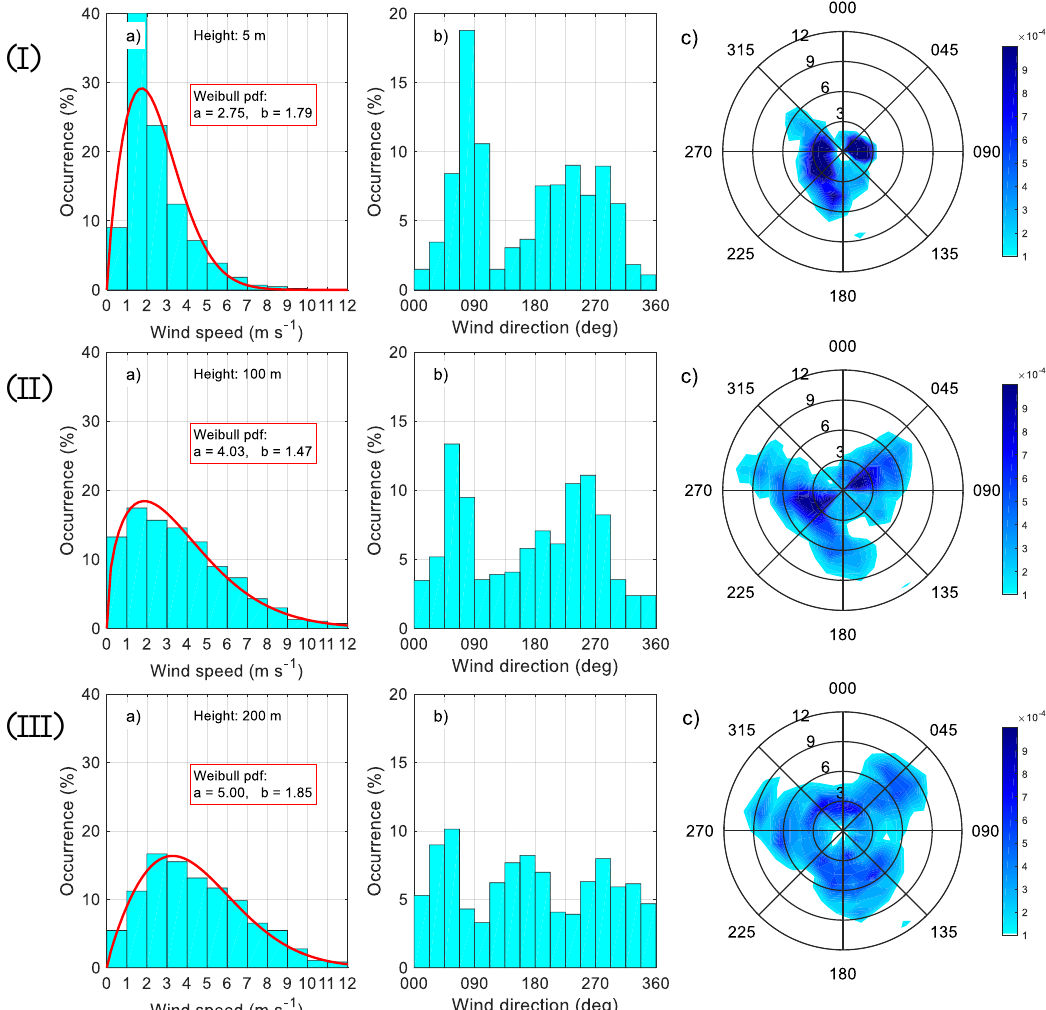
Figure 7. Histograms of ( a ) wind speed and ( b ) wind direction, as well as ( c ) occurrence wind rose diagrams at different heights and different wind speeds values for the summer months June–August in 2015–2016. Upper panel (I): Sonic anemometer measurements at 5 m; middle (II) and lower (III) panels: Sodar measurements at 100 and 200 m, respectively. The wind rose diagram shows the joint probability distribution of wind speed and wind direction (where the colour intensity is proportional to the value of the joint probability density function). Red lines are the fitting Weibull distributions.